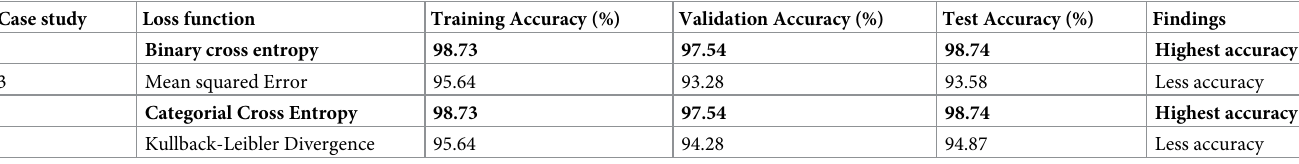
Table 11. Performance analysis by changing loss